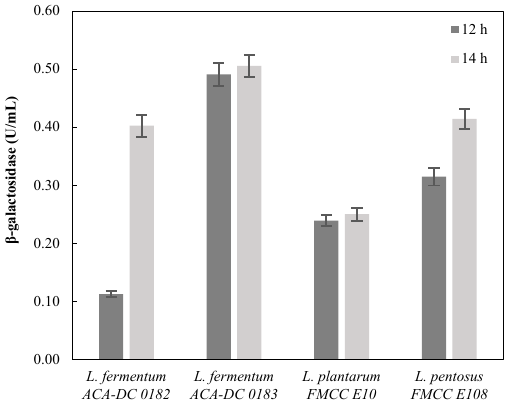
Figure 3. β -galactosidase of lactobacilli strains ( L. fermentum ACA-DC 0182 and 0183; L. plantarum FMCC E10 and L . pentosus FMCC E108) on MRS medium after 12 h and 14 h of preculture.